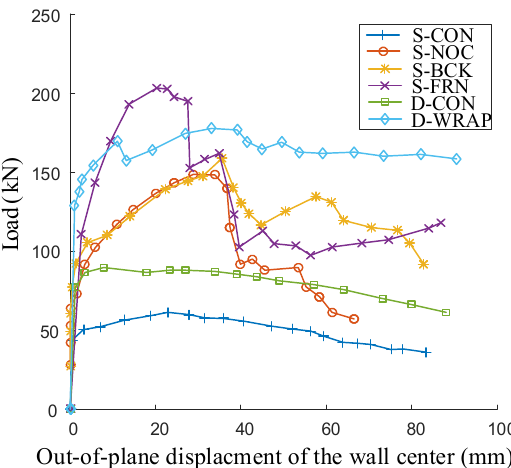
Figure 19. Load displacement out-of-plane response at the center of infill walls under different rehabilitations [97].